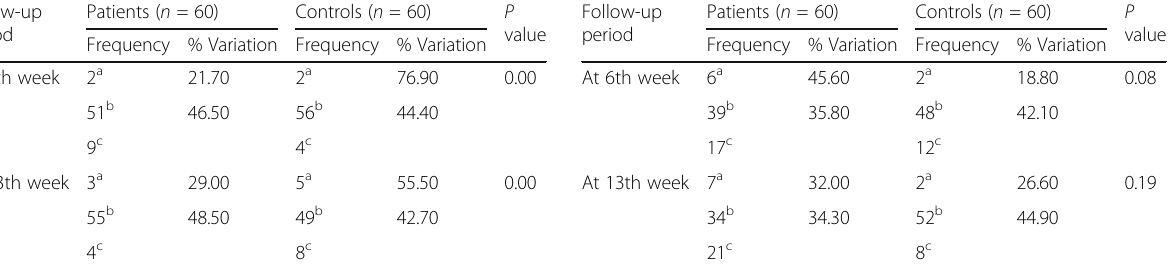
Table 4 Percentage variation in height of participants at the 6th and 13th week Follow-up period